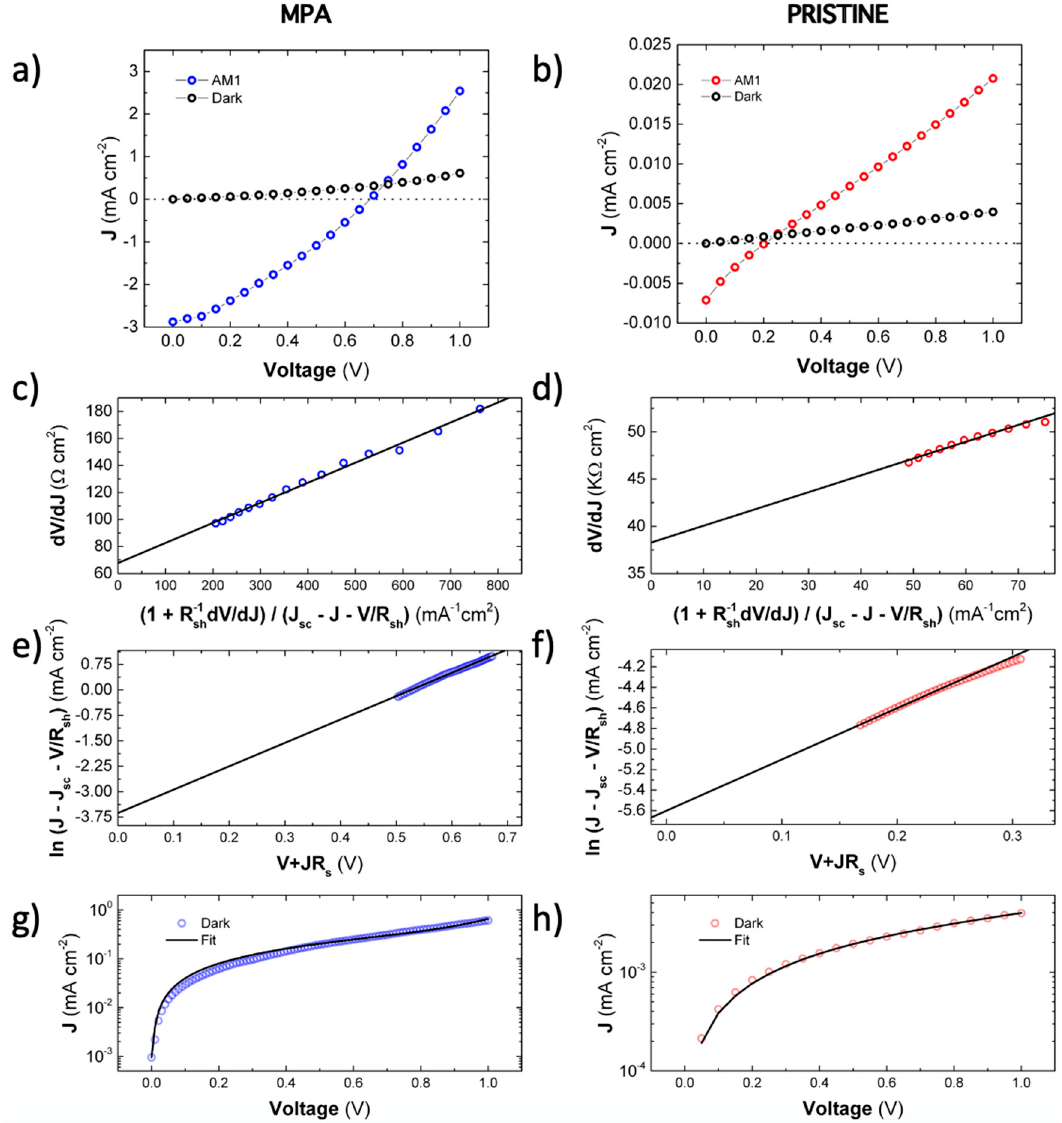
Figure 4. J - V curves for planar PNC photodiodes using ITO / PEDOT:PSS / CsPbBr 3 PNCs / MoO 3 / Au architecture. The measurements are carried out in dark and under AM1.5G for MPA ligand-exchanged ( a ) and pristine ( b ) devices. Fitting curves (continuous black lines) using Equations (4)–(5) for J - V curves under AM1.5G illumination for MPA ( c – e ) and pristine ( d – f ) devices, and Equation (7) for J - V under dark conditions in MPA ( g ) and pristine ( h ) cases.